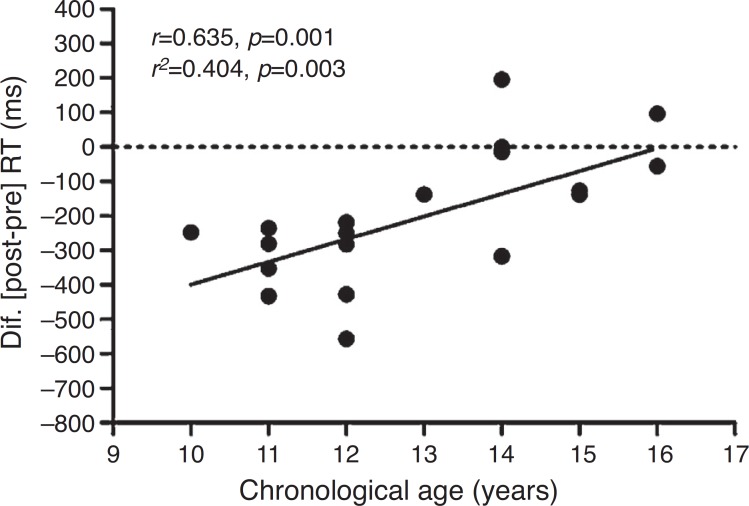
Linear regression (r
2) and Pearson's coefficient correlation (r) between the delta (Δ=post-pre) of the incongruent reaction time (RT) of Stroop test Phase 3 of the exercise session with chronological age.